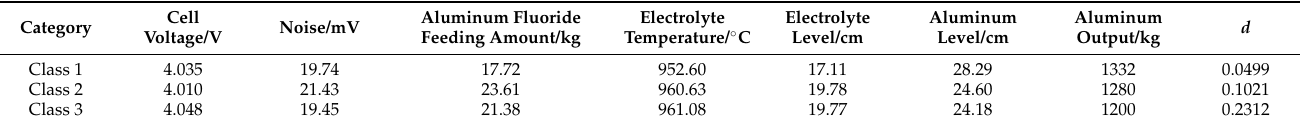
Table 1. Cluster sample center.